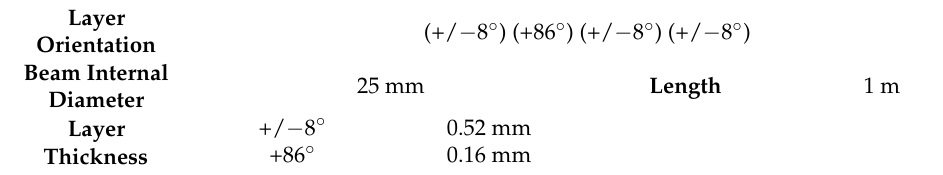
Table 3. CFRP Composite Beam Properties.